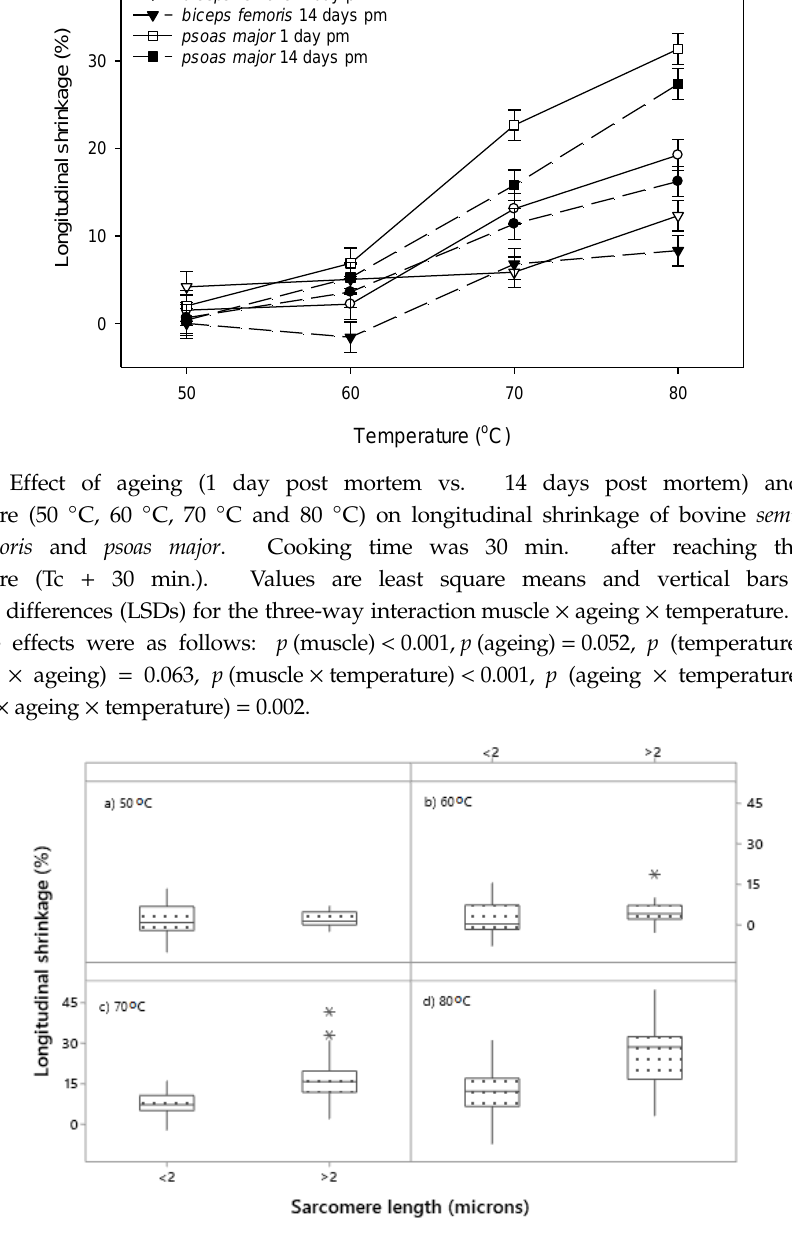
Figure 5. Relationship between longitudinal shrinkage and sarcomere length. Boxplot of the longitudinal shrinkage of muscles with < 2 and > 2 µ m sarcomere length; cooked to ( a ) 50 ◦ C, ( b ) 60 ◦ C, ( c ) 70 ◦ C, ( d ) 80 ◦ C; n = 82. A 2- µ m threshold was chosen as median of the dataset. Data were combined from three bovine muscles ( semitendinosus , biceps femoris and psoas major ) from five carcasses. Cooking time was 30 min. after reaching the defined temperature (Tc + 30 min.). Asterisks indicate extreme outliers.